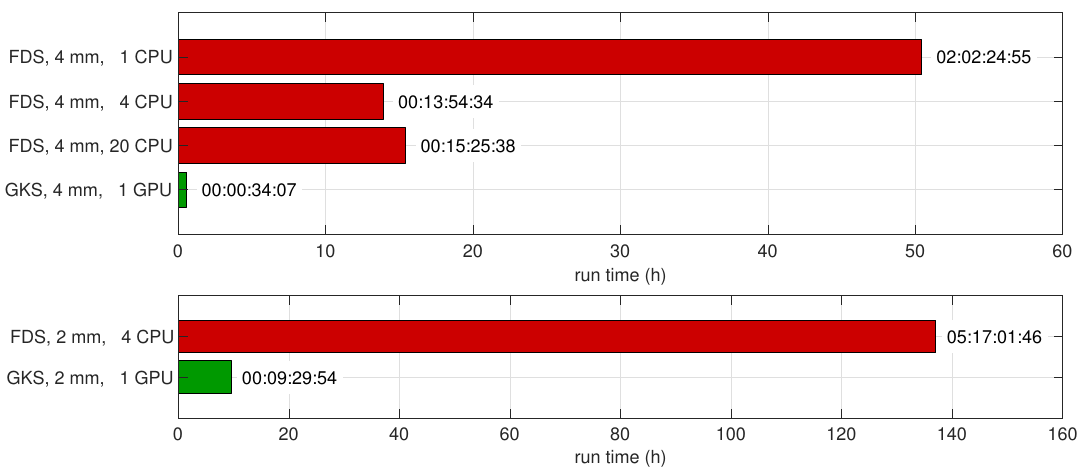
Figure 10. Purdue flame: time required for FDS and GKS simulations to simulate flame evolution for 20s. The CPUs used are INTEL Xeon E5-2640v4, and the GPUs used are NVIDIA Tesla